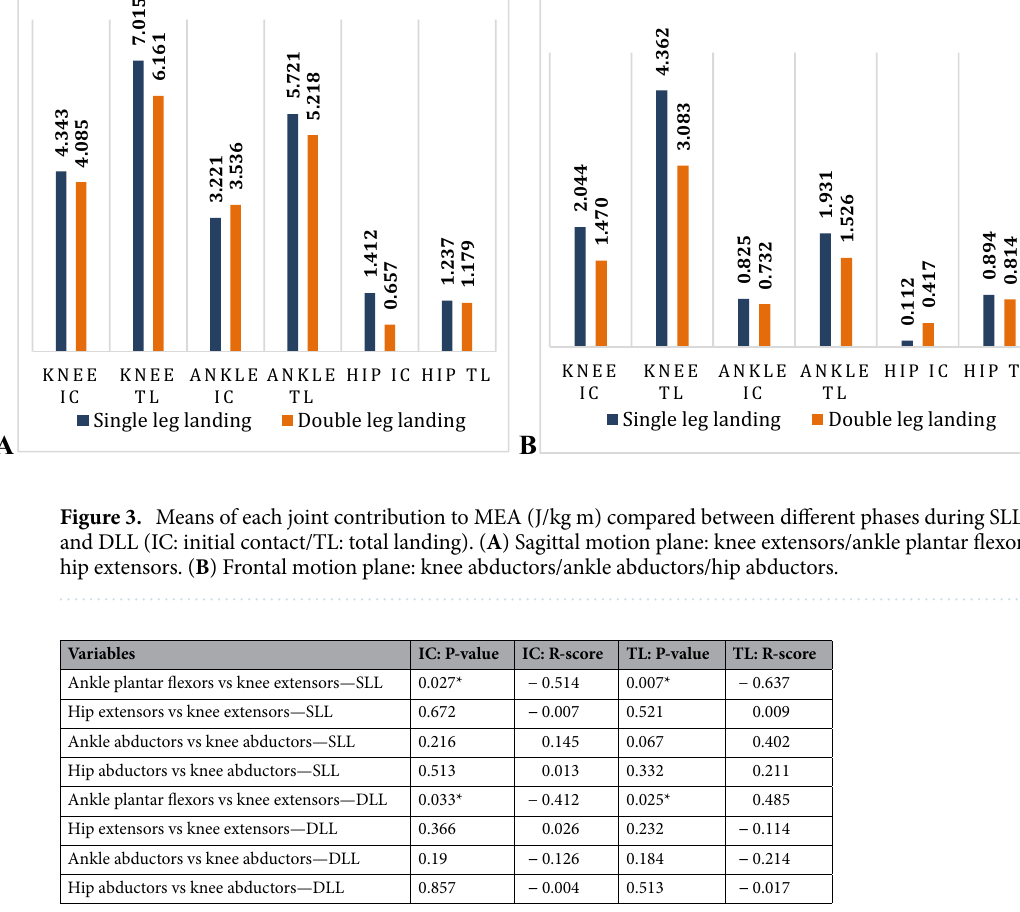
Table 3. Compensated MEA (J/kg m) strategies relative to knee joint in sagittal and frontal motion planes at IC and TL during SLL and DLL/* = Significant variables/ negative R-score = inverse correlation, positive R-score = positive